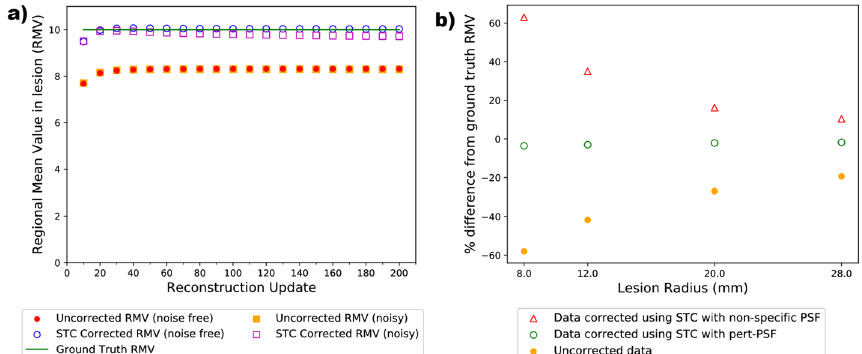
Fig. 7 a Regional mean values (RMVs) measured for a lesion in the simple cylindrical phantom with 36 mm radius, TBR 10, positioned centrally in FOV, for different image reconstruction update numbers. Note that = the uncorrected noise‑free and noisy datasets overlay each other. b Deviation in RMV from ground truth (in %) following STC with perturbation‑estimated PSF or the non‑specific PSF, for off‑centre lesions and a range of lesion sizes. All lesions had TBR 10, and all images used 200 reconstruction =